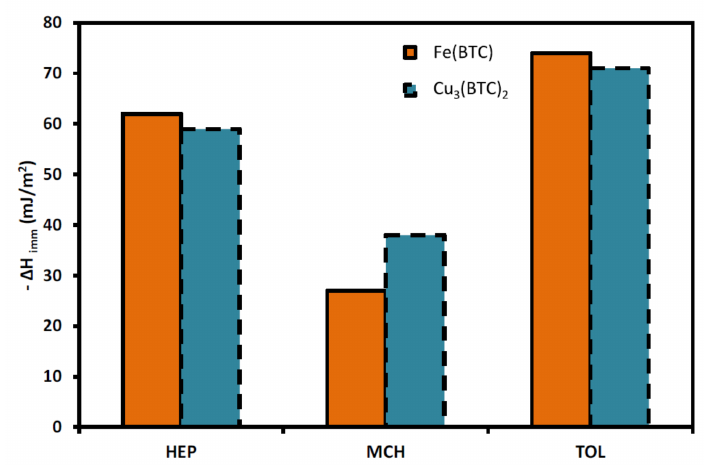
Figure 7. Enthalpy of immersion for Fe-BTC and HKUST-1 for the three adsorbates. Reprinted with permission from [58]. Copyright (2015) Elsevier.